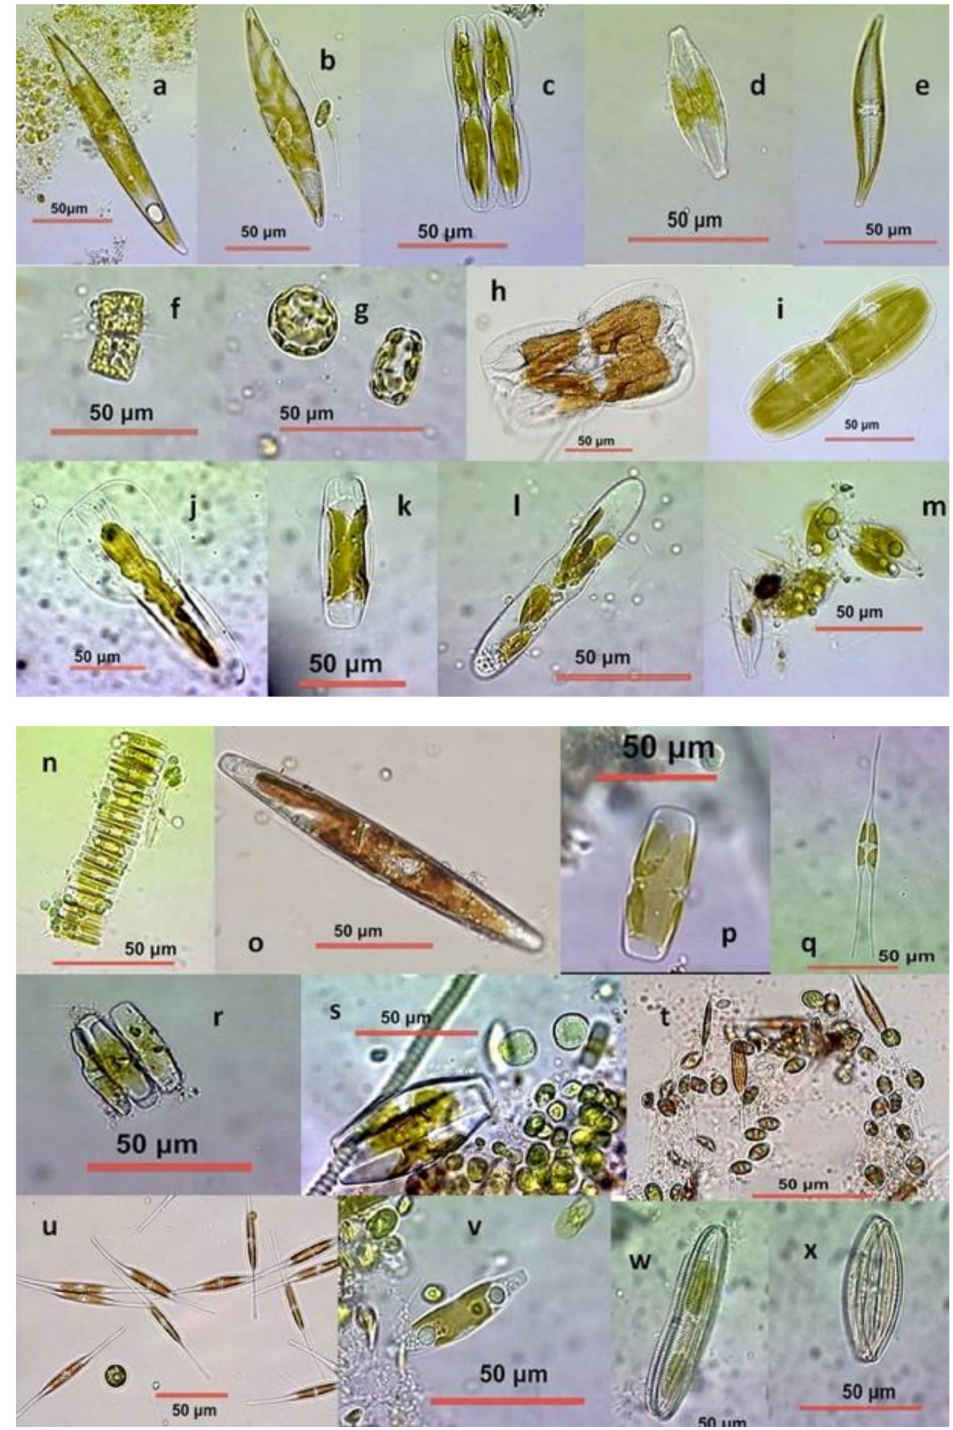
Figure 3. Diatoms from hypersalinity. ( a ) Pleurosigma sp., lateral view; ( b ) Pleurosigma sp., girdle view; ( c ) Entomoneis sp.; ( d ) Navicula sp.; ( e ) Gyrosigma sp.; ( f ) Cyclotella sp. dividing; ( g ) Cyclotella sp. round and elongated form; ( h ) Entomoneis sp.; ( i ) Amphiprora sp.?; ( j ) Gomphonema sp.?; ( k ) unidentified cym- belloid species; ( l ) Pinnularia sp.?; ( m ) Cymbella sp.; ( n ) Eunotia sp.?; ( o ) Nitzschia sp.; ( p ) unidentified diatom; ( q ) Nitzschia dividing; ( r ) Eunotia sp.?; ( s ) Cymbella sp.; ( t ) Cocconeis sp.; ( u ) Cylindrotheca sp.; ( v ) Craticula sp.; ( w ) Epithemia sp.?; ( x ) Diatoma sp.(same scale bar as that in